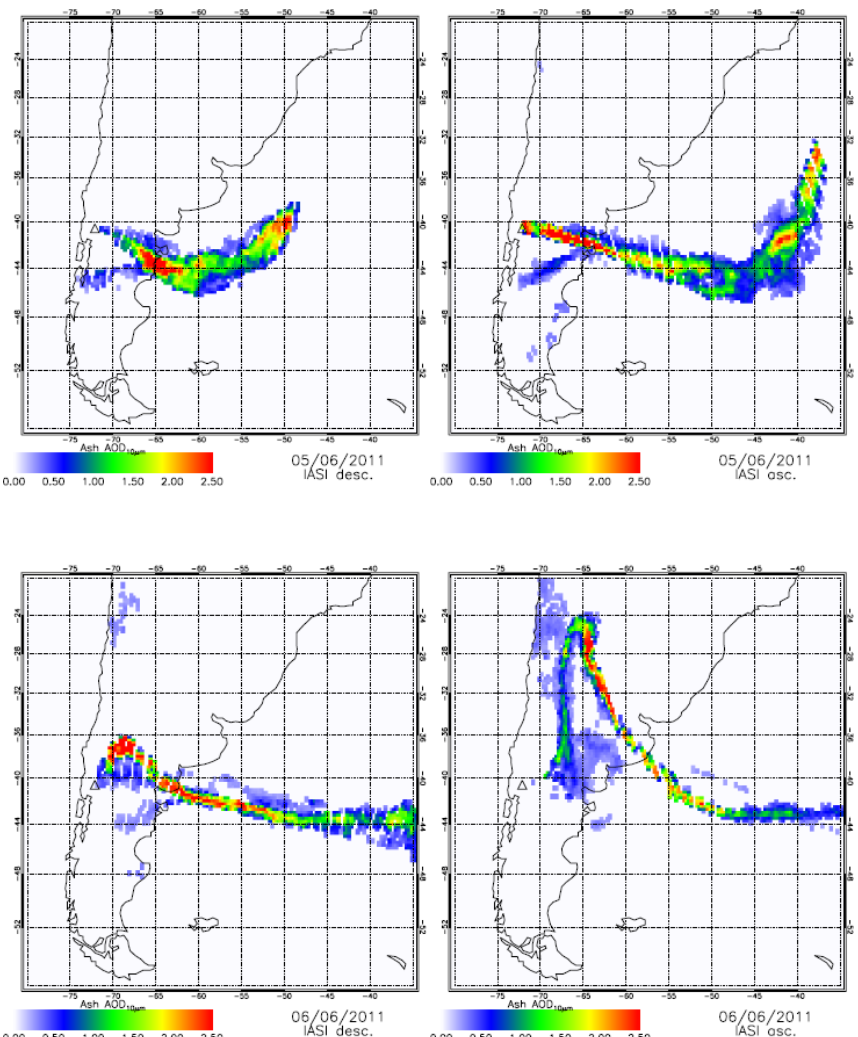
Figure 10. Figure by L. Klüser, T. Ebersteder and J. Meyer-Arnek, published in Klüser et al. (2013) as Fig. 2, with the following description: “Ash Optical Depth at 10µm of the PCCE plume for 5 through 6 June. Descending (desc.) orbits represent morning observations, ascending (asc.) orbits are from local evening. The black triangle indicates the position of the